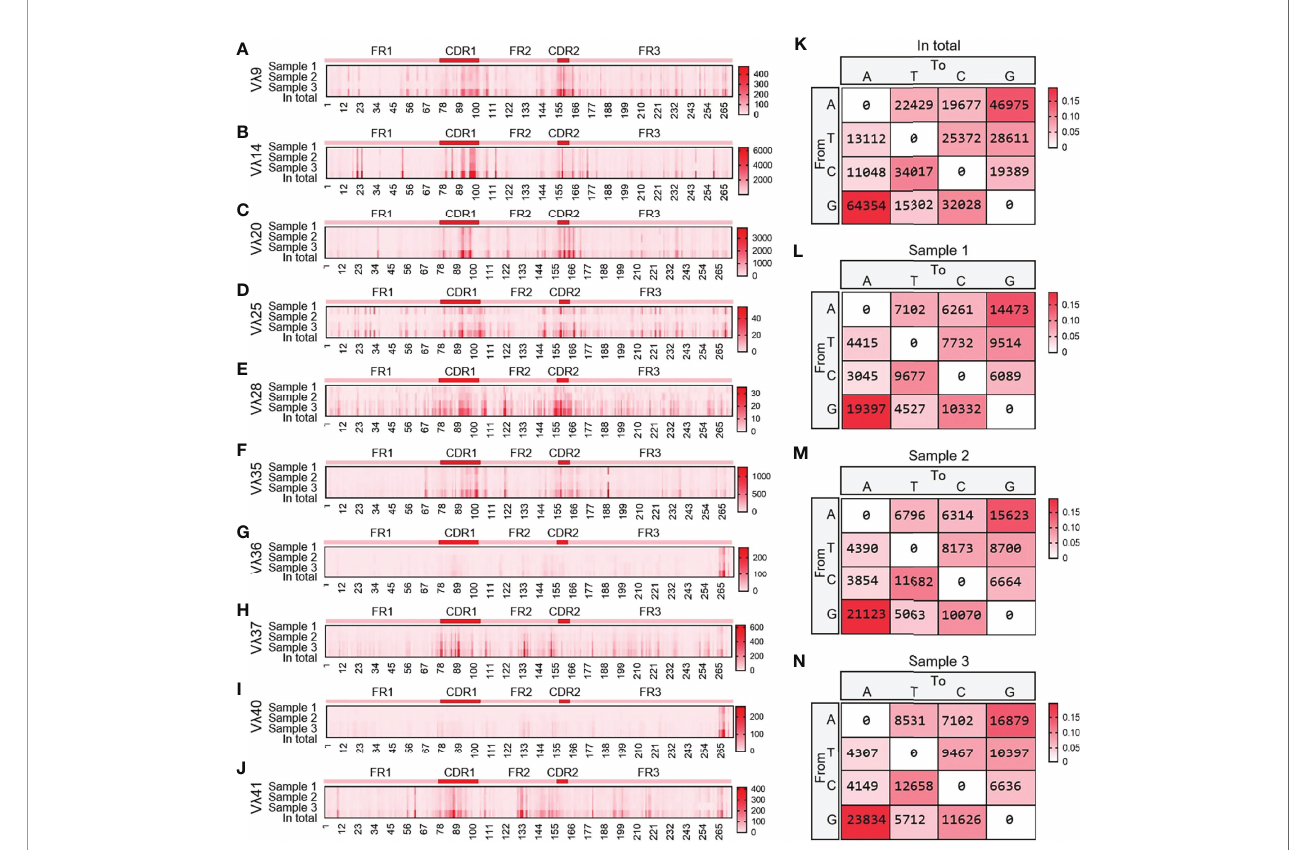
FIGURE 13 | The somatic hypermutation (SHM) of yak IgL( l ). (A – J) The distribution of SHM in yak IgL( l ); (K – N) The base mutation types of SHM in yak IgL( l